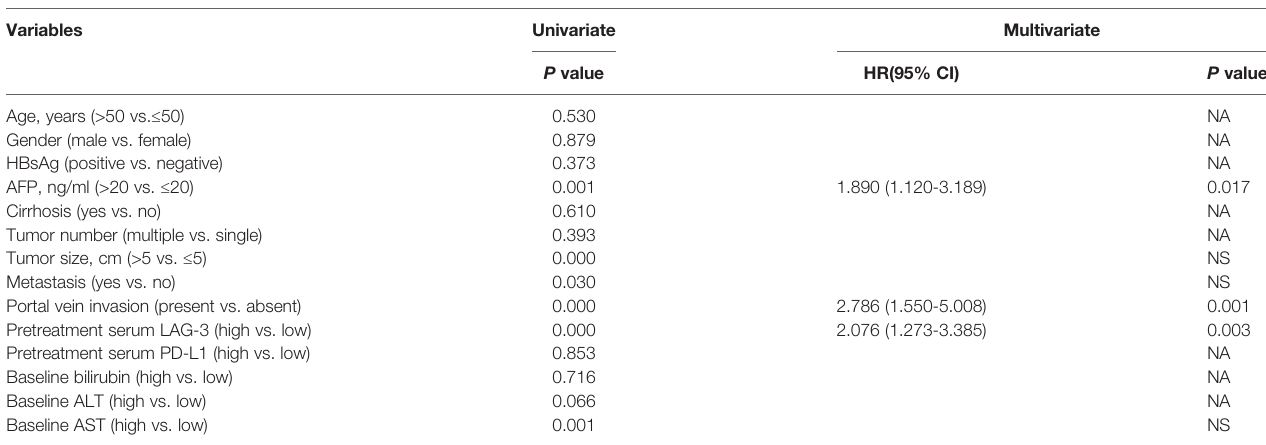
FIGURE 3 | Prognostic signi fi cance of pre-TACE serum LAG-3 and PD-L1 levels in HCC underwent TACE. Kaplan – Meier analysis of OS based on the serum LAG-3 level (A) , serum PD-L1 level (B) and the combination of the serum levels of LAG-3 and PD-L1 (C) . Differences between groups were evaluated using log-rank test. The number of patients at risk was reported. OS, Overall survival. TABLE 4 | Univariate and multivariate analysis for